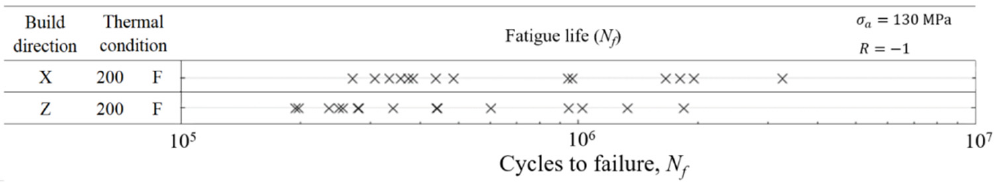
( b ) Figure 12. Probability of failure (%) vs. number of load cycles, N . The probability density function of log-normal distribu- tions is fitted to each series of experimental results. The stress amplitude was 135 MPa for the 35 °C, 60 °C and 80 °C, X ( a ) and Z ( b ) building conditions.